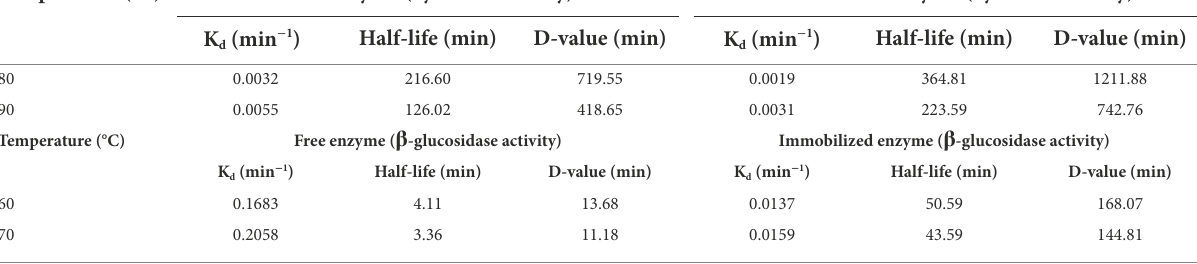
TABLE 2 K d , half-life and D-value of xylanase and β -glucosidase activities of free and immobilized PersiXynBGL1. Temperature